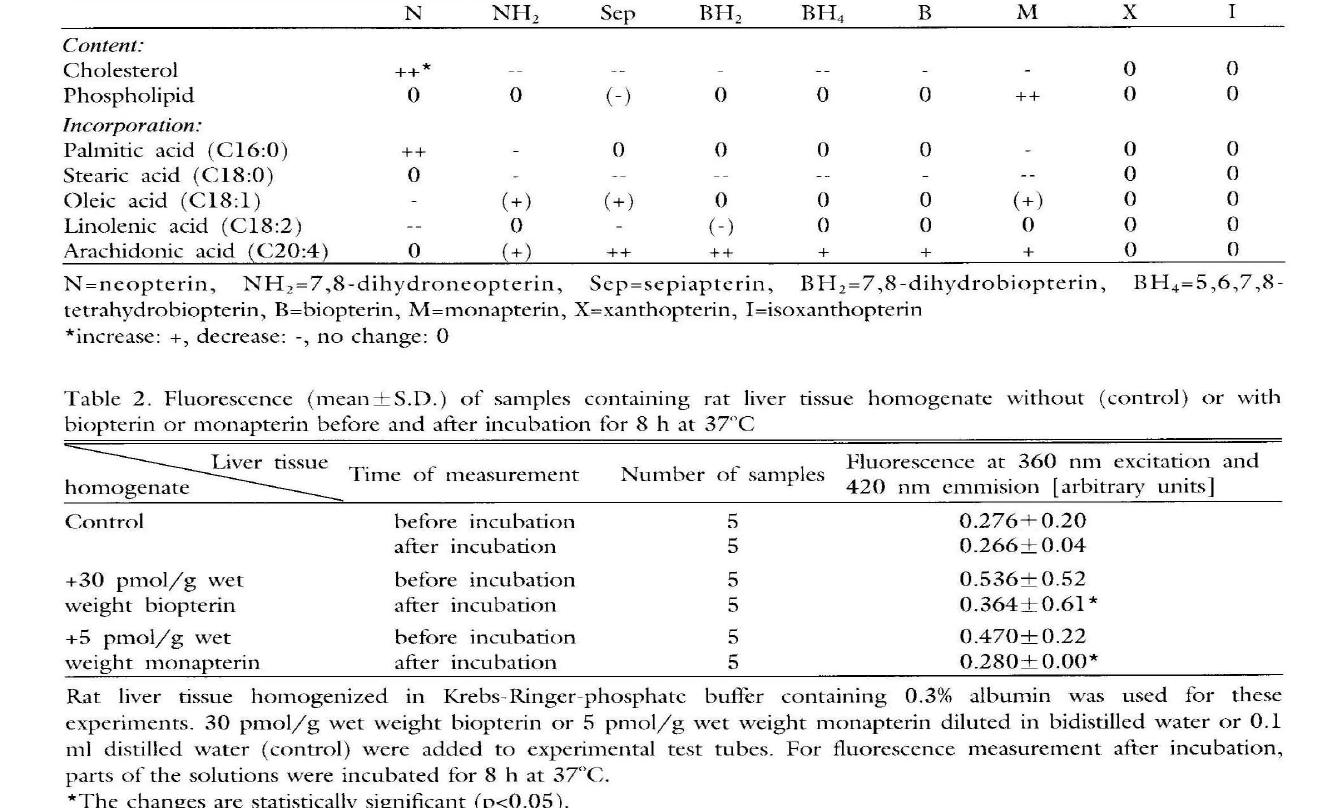
Table 1. Influence of different pteridine derivatives on cholsterol and phospholipid content and on fatty acid in corporation into phospholipids in rat liver tissue homogenates (Surnmary of Figures 1-9)